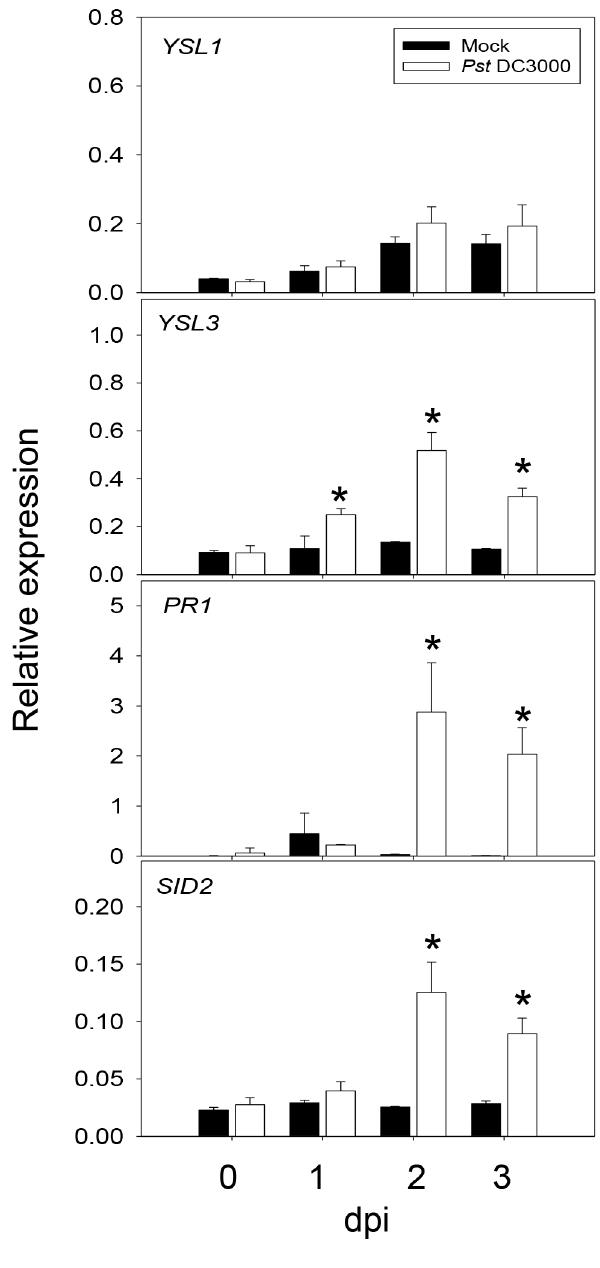
Figure 4. Expression of YSL1,YSL3 , PR1 and SID2 in Arabidopsis leaves infected with Pst DC3000. Four-week-old plants of Arabidopsis wild type (Col-0) were spray-inoculated with Pst DC3000 solution. Plants sprayed with 10 mM MgCl 2 with 0.02% Silwet L-77 were used as a mock treatment control. Mature leaves (3rd) were collected 0, 1, 2 and 3 days post-inoculation (dpi). qPCR analysis of expression of YSL1, YSL3, PR1, SID2 and PLANT DEFENSIN1.2 ( PDF1.2 ) relative to that of ACT2 . Data are mean 6 SD from 6 samples of 2 biological repeats. *P , 0.05 compared with mock inoculation.